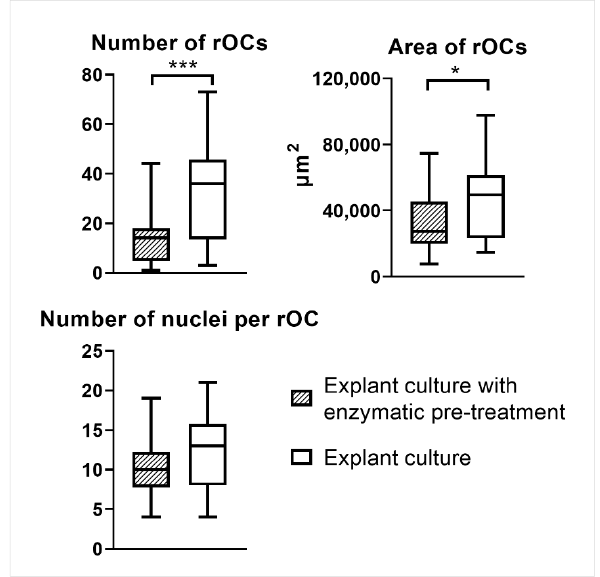
Figure 9. The number of formed rOCs per well, their area, and the number of nuclei per rOC in a co-culture with rOBs isolated either by explant culture with enzymatic pre-treatment or by explant culture. The shown data were analyzed for co-cultures with exogenous GFs (M-CSF, RANKL) on day 14. The statistical difference is marked as a link above the groups. * p < 0.05, *** p < 0.001.